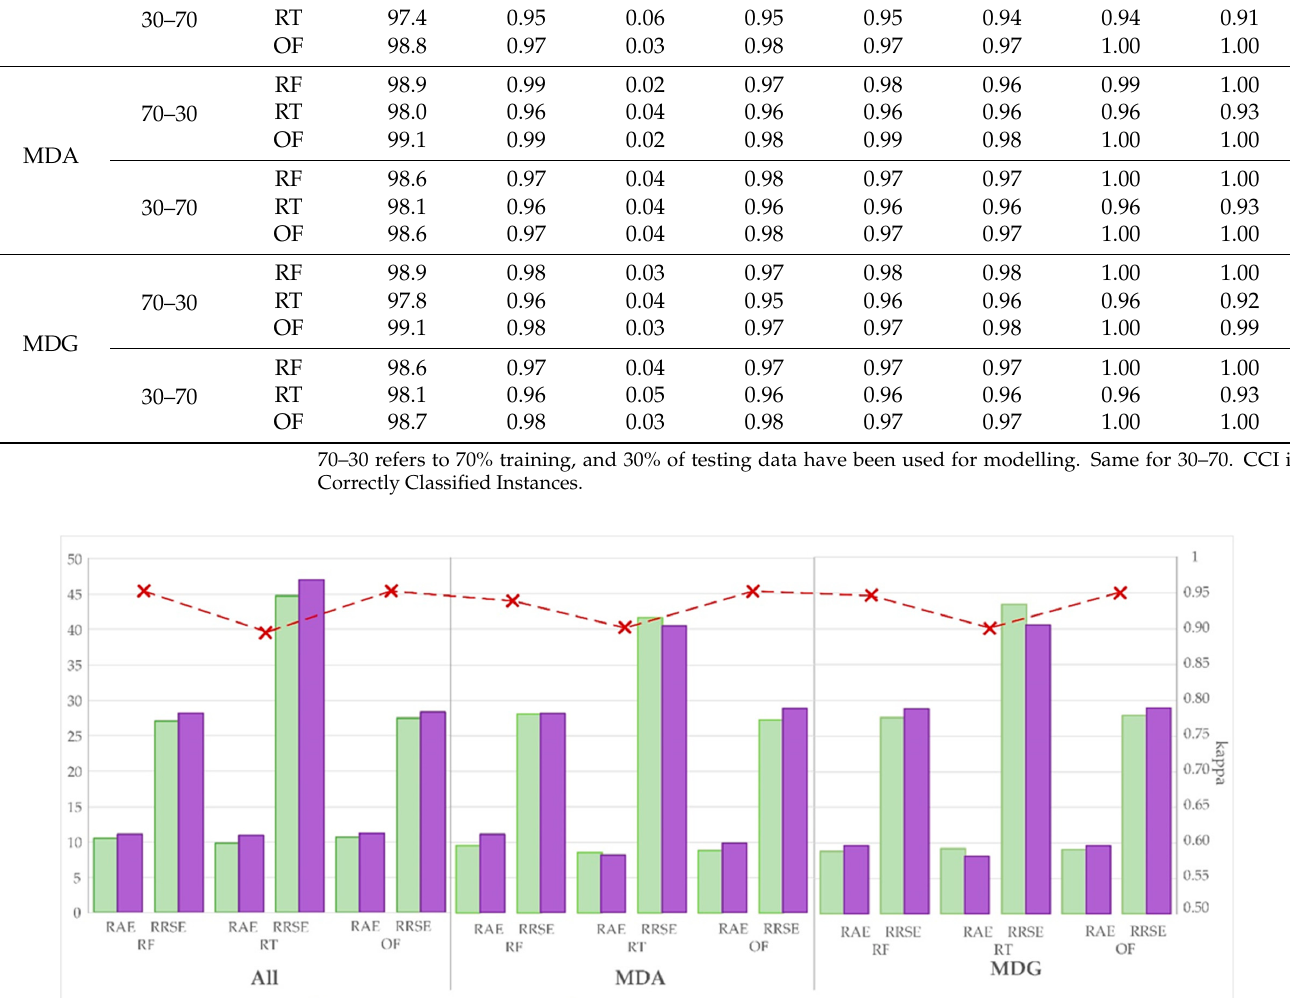
Figure 10. Accuracy assessment of the used modeling methods and variable selecting strategy.